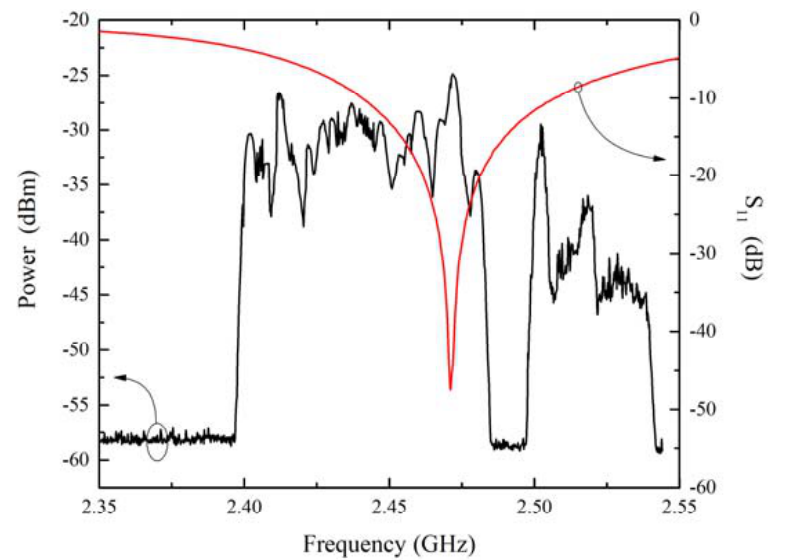
Figure 8. Max-hold ambient RF power spectrum measurement, between 2.35 GHz and 2.55 GHz (in black and left-scale); S 11 of the RF rectifier with 6.8 mF and 10 k Ω load in the output (in red and right scale).